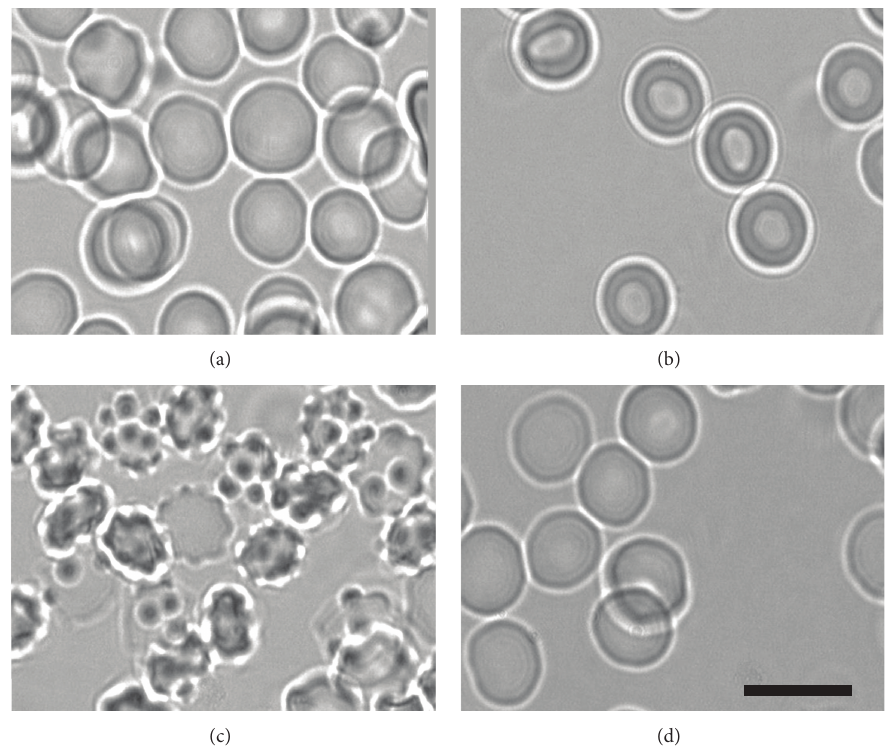
Figure 2: Effect of the local anesthetic lidocaine/epinephrine (L/E) on the erythrocyte shape. (a) Blood dissolved in phosphate buffered saline (PBS), (b) blood dissolved in PBS with added L/E (stomatocytosis), (c) echinocytosis was induced by centrifugation of blood dissolved in PBS, and (d) echinocytes dissolved in PBS transformed into discocytes after the addition of L/E to the suspension. Bar = 10 𝜇 m.